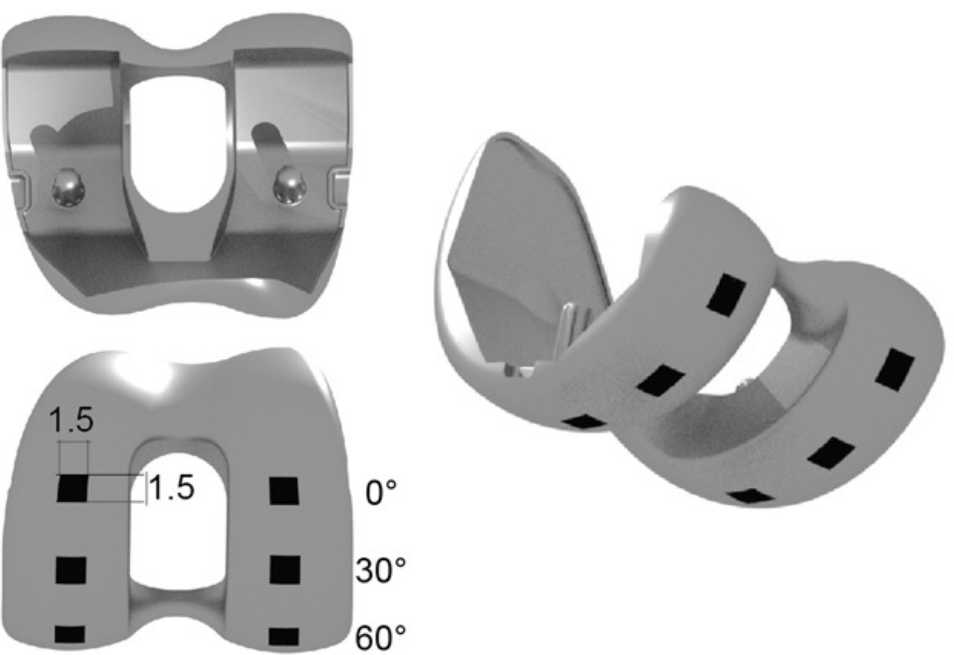
Figure 1. Areas on each femoral condyle in which were performed the roughness measurements. Three main roughness indices were considered to characterize the roughness of the specimens: Ra, Rt, and Rsk. The most significant indicator to characterize the surface conditions is the mean roughness, Ra, that represents the amplitude of the arithmetical